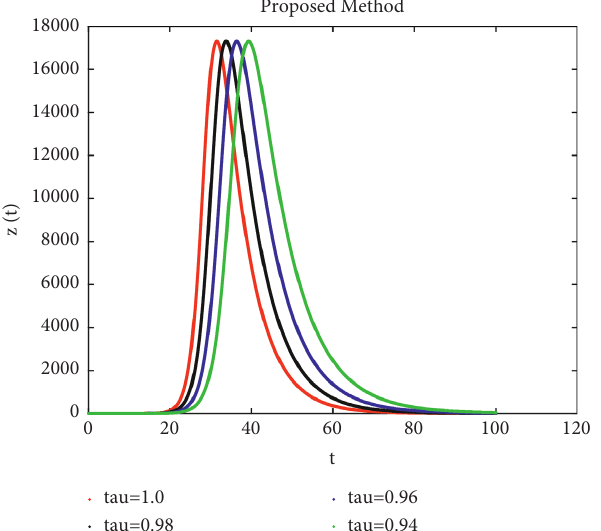
Figure 7: Dynamical behavior of free HIV virus particles at τ � 1 and various fractional order under power law kernel.